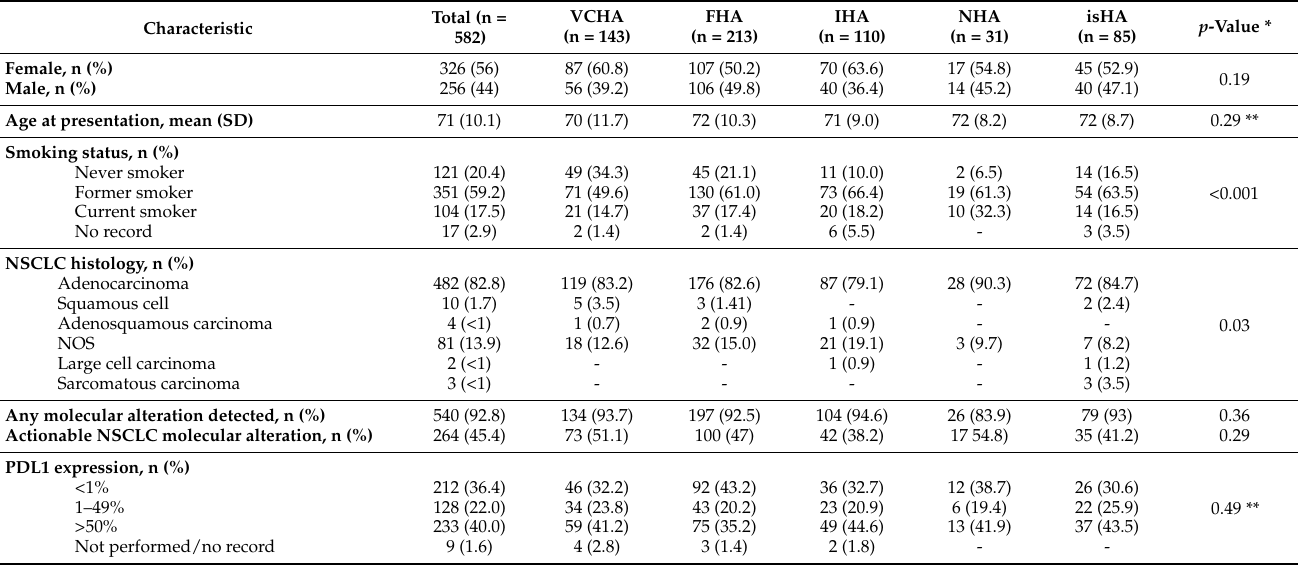
Table 1. Demographic and tumor characteristics for the total cohort (May 2020 to June 2021) and actionable NSCLC gene